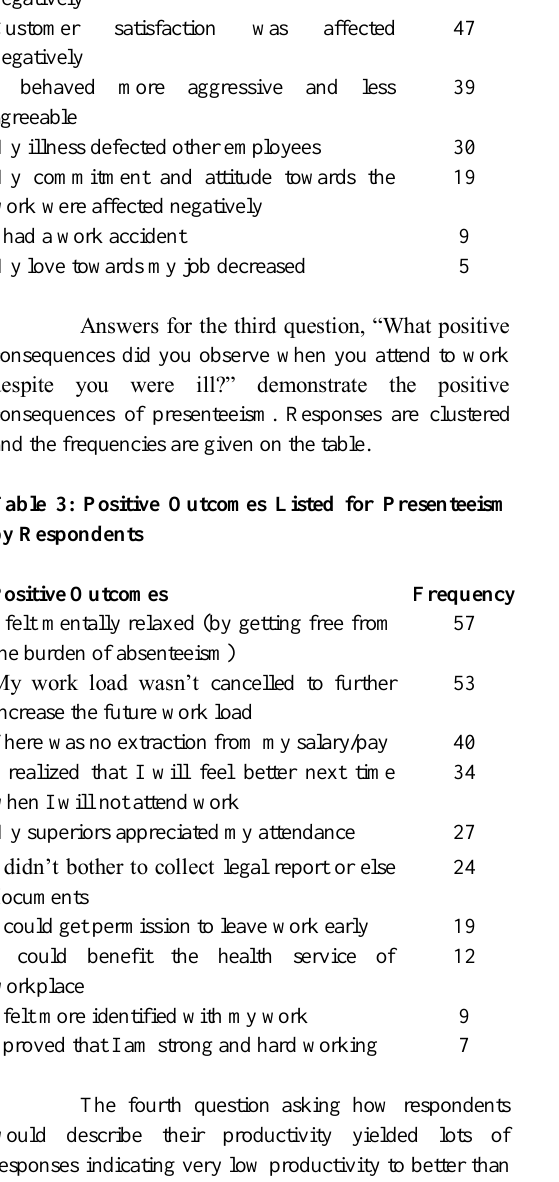
Table 4: Criteria Used For Deciding on